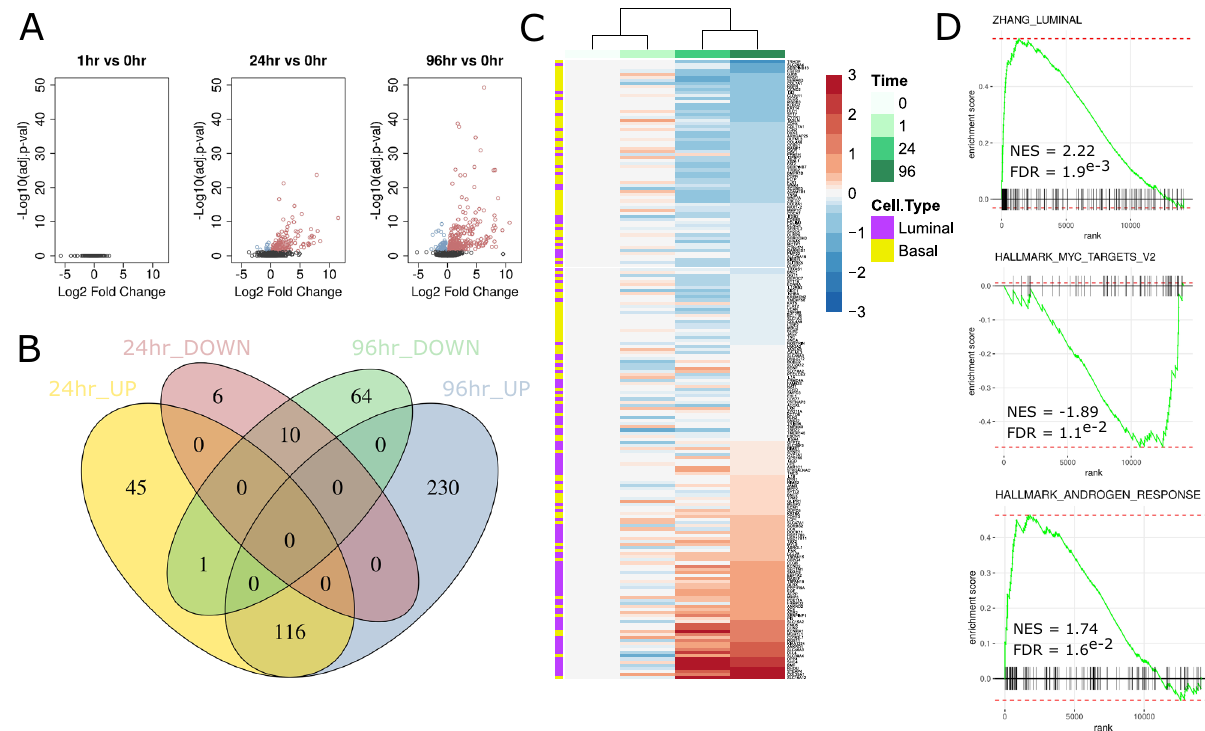
Figure 1. Global transcriptional patterns associated with androgen induced differentiation in HPr1-AR cells. ( A ) Volcano plots depicting expression changes at each time point (1 h, 24 h, 96 h) relative to untreated cells (n = 4 at each time point). ( B ) Venn diagram of DEGs identified at 24 and 96 h of DHT exposures. ( C ) Heatmap of top 100 luminal and basal differentiating genes as identified by Zhang et al. 4 . ( D ) Select enrichment plots from GSEA analysis comparing 96 h of DHT exposure to 0